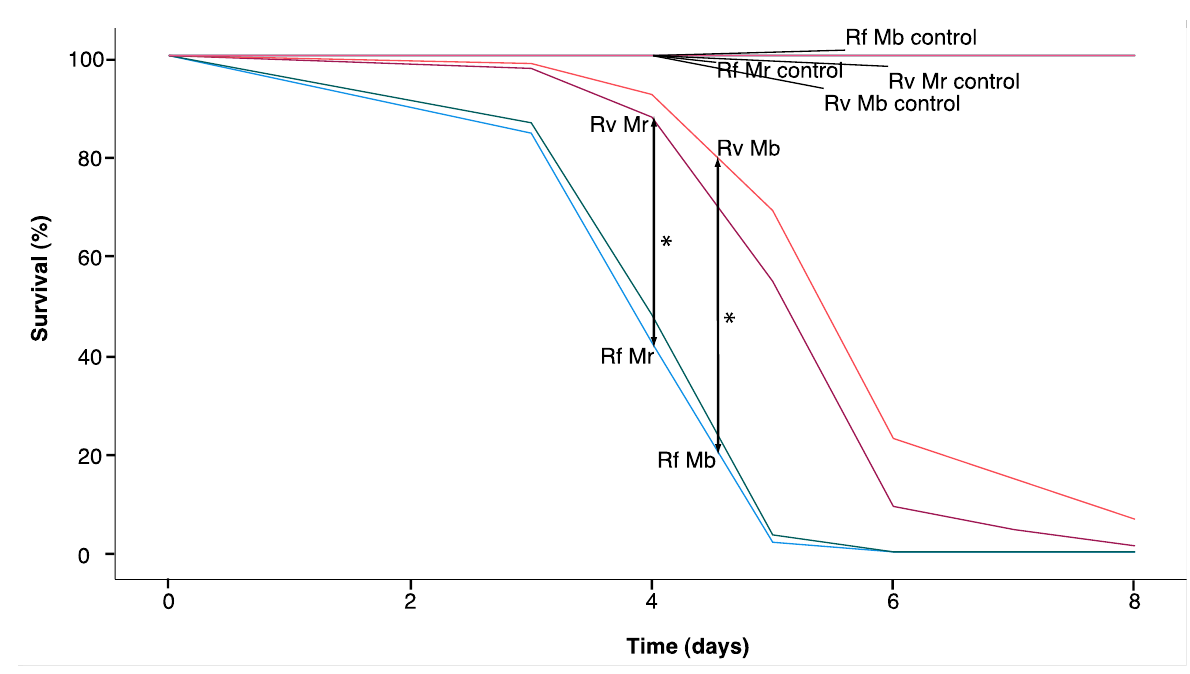
Figure 4. Survival of single termites after a fungal challenge (n = 96). Rf corresponds with R. flavipes , Rv with R. virginicus , Mr with M. robertsii and Mb with M. brunneum . See text for details on statistical differences between treatments. Significant survival differences for pairwise comparisons were based on Breslow tests (generalized Wilcoxon tests). * Significant difference between treatments ( p < 0.025 Bonferroni adjusted α